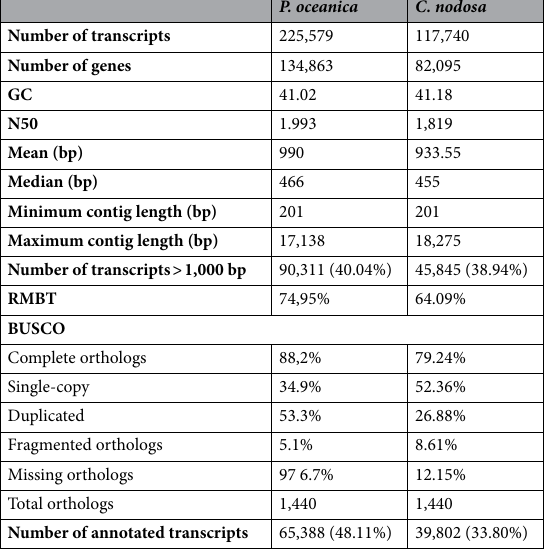
Table 3. Summary statistics of Posidonia oceanica 85 and Cymodocea nodosa de novo transcriptomes used in the present study. GC = the proportion of guanine and cytosine nucleotides among total nucleotides; N50 = the length of the longest contig such that all contigs of at least that length compose at least 50% of the bases of the assembly; RMBT = percentage of reads that mapped back to transcripts in each final assembly ; BUSCO: Benchmarking Universal Single‑Copy Orthologs